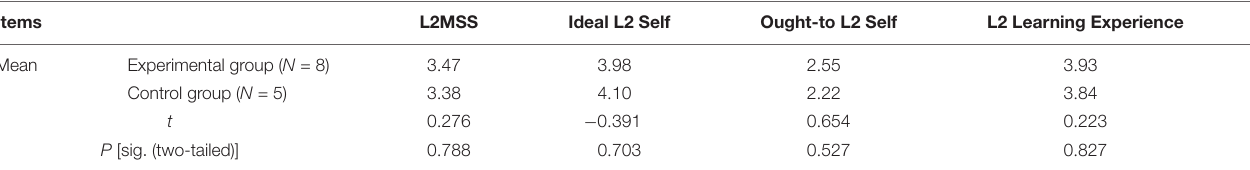
TABLE 3 | L2MSS of the two groups before the first interview.